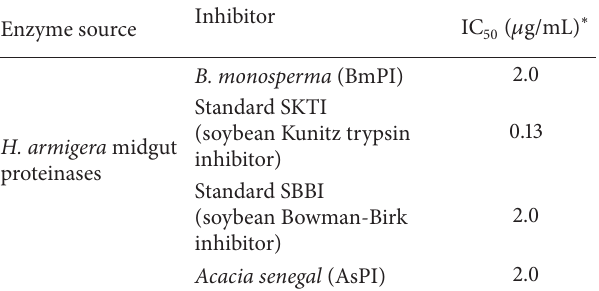
Table 2: IC ( 𝜇 g/mL) values for both PIs and standard PIs. 50 Except for value of BmPI, others have been adapted from Babu and Subrahmanyam